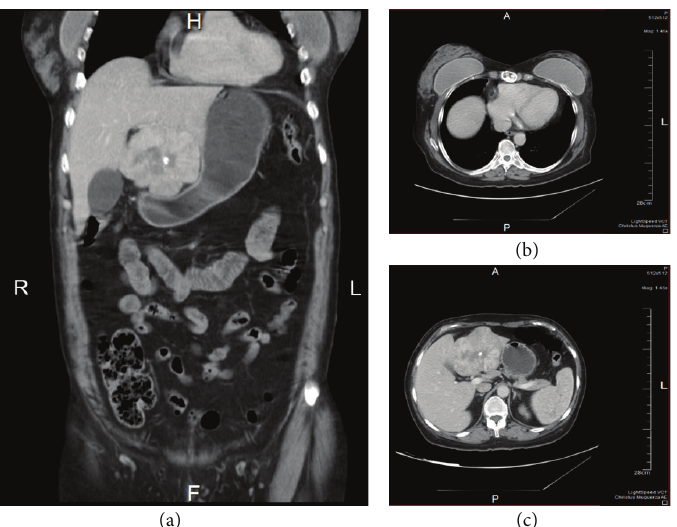
Figure 2: Images from the abdominal CT. (a) and (b) show the 8 × 8 × 7.3cm tumor located in segment IV of the left lobe of the liver that laterally displaces the gallbladder. The lesion has defined lobular borders that show a heterogeneous peripheral areas and a hypodense center with calcification. (c) shows changes in the sternum with presence of surgical material.